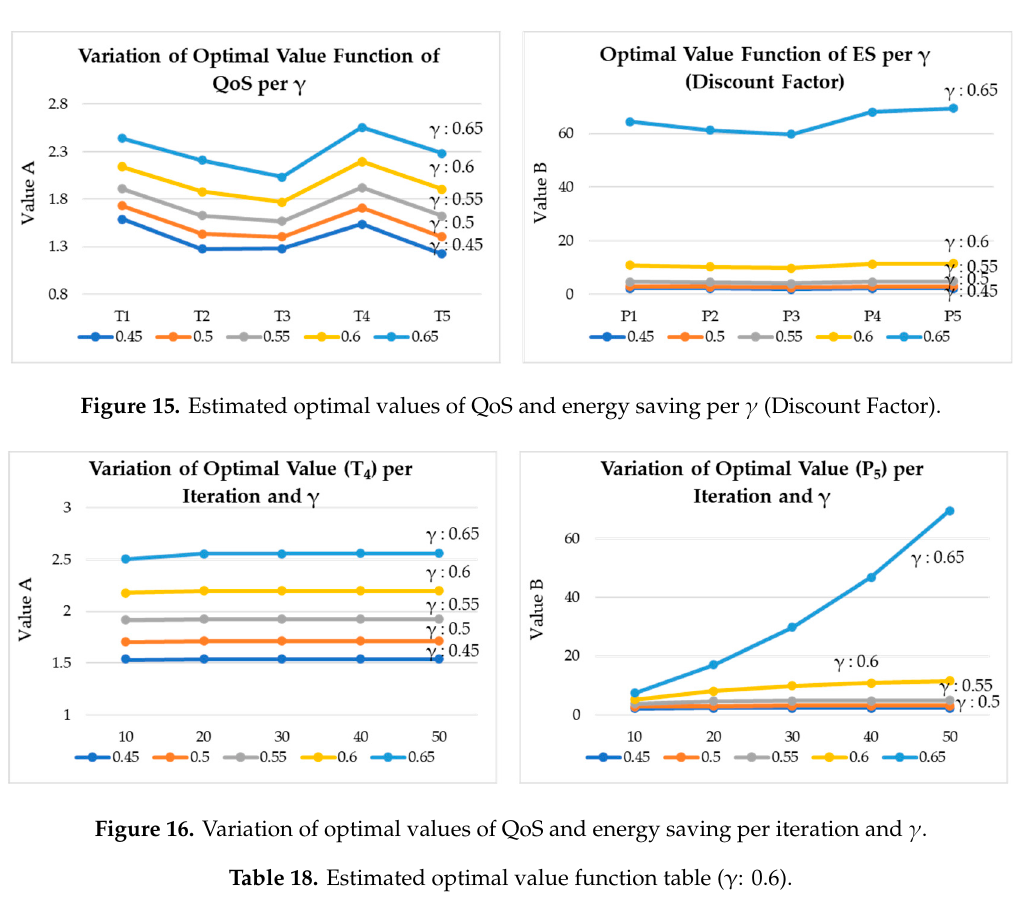
Figure 14. Estimated optimal values of QoS and energy saving per iteration.